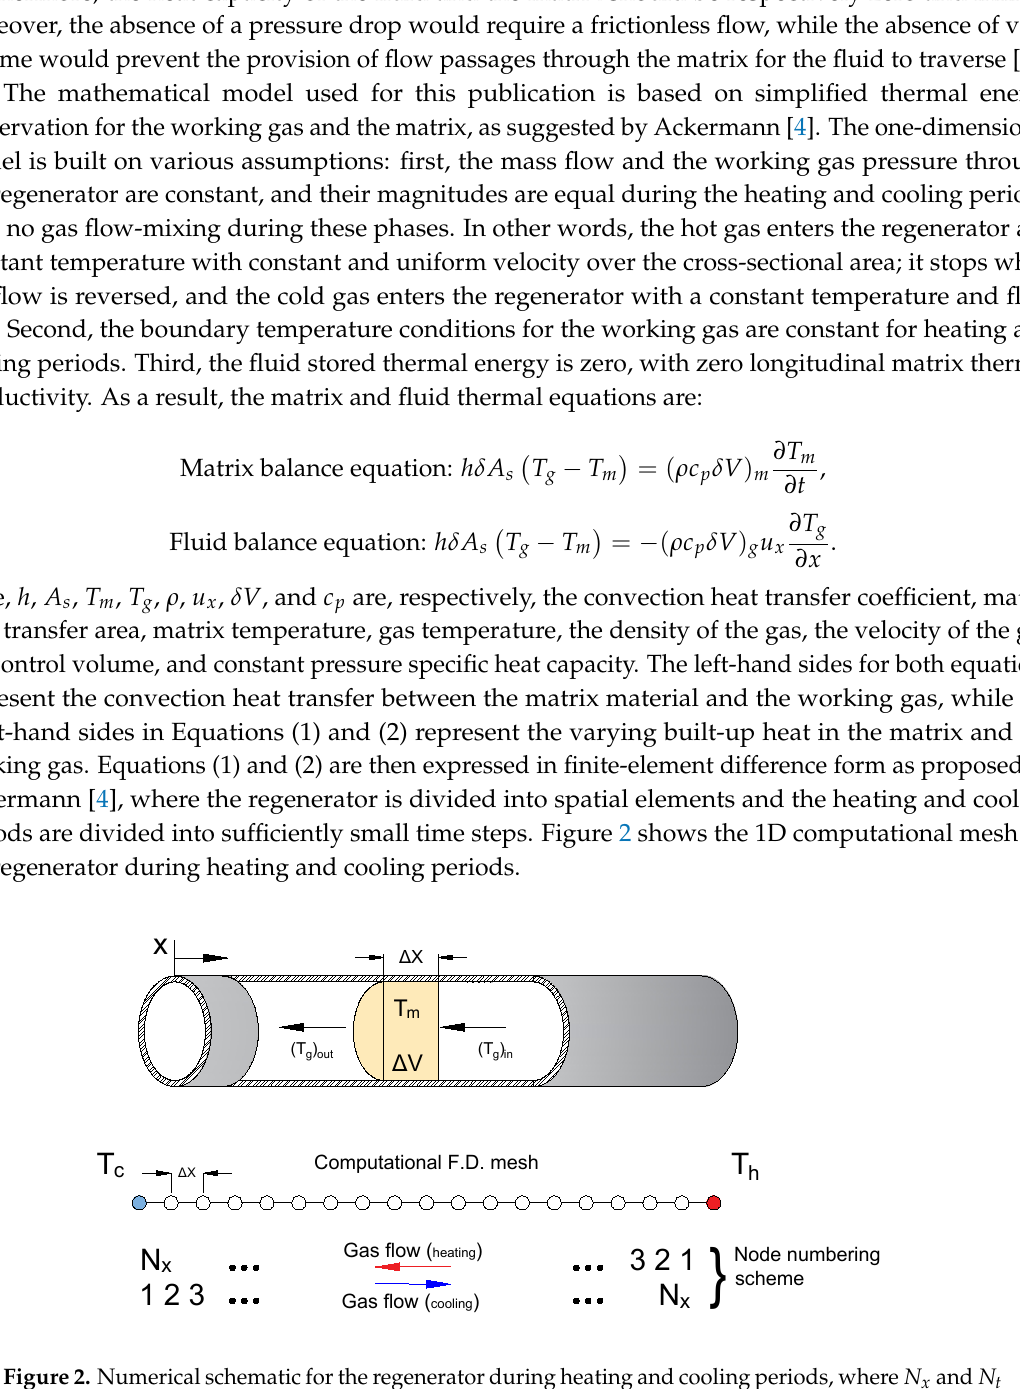
Figure 2. Numerical schematic for the regenerator during heating and cooling periods, where N x and N t are the total number of spatial and time elements and T h and T c are the hot and cold temperature